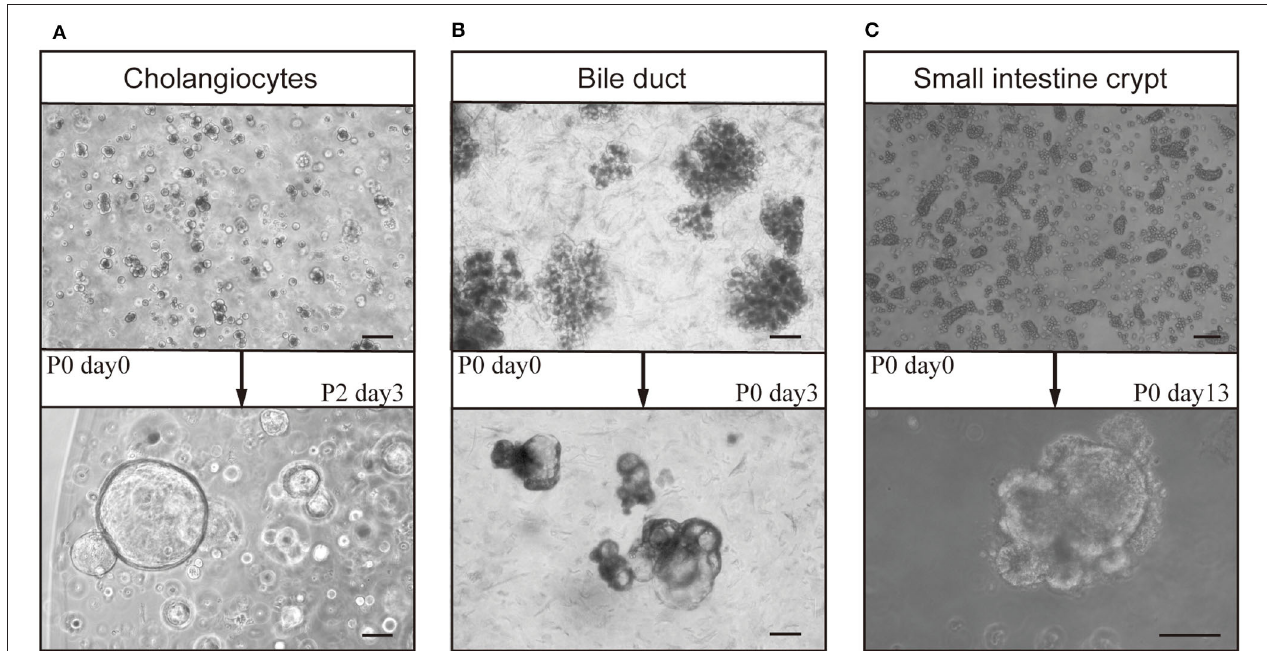
FIGURE 2 | Culture of organoids from bile ducts and small intestines of mice. After gravity settling and multi-step centrifugation, cholangiocytes (derived from bile ducts), bile ducts, and crypts from the small intestine formed organoids after ∼ 14 days in culture. Cholangiocytes (day 0) from (A) bile ducts formed cholangiocyte organoids (cho-orgs) (day 3, passage 2) (bar, 100 µ m), and those from (B) intrahepatic bile ducts (day 0) formed cho-orgs (day 3) (bar, 100 µ m). (C) Crypts from the small intestine (day 0) (bar, 200 µ m) formed small intestinal organoids (in-orgs) (day 13) (bar, 100 µ